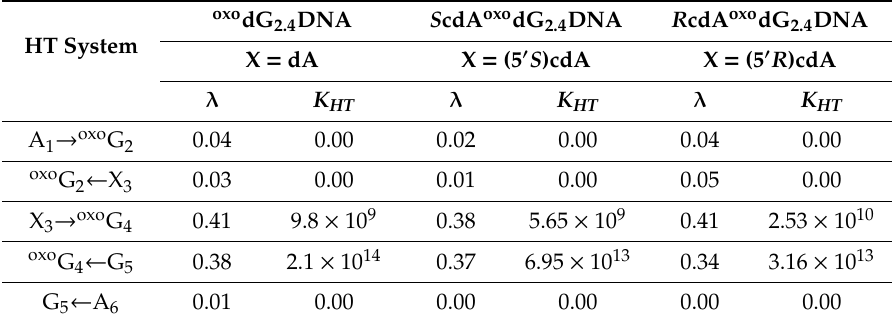
Table 1. The λ [eV] and K HT [s − 1 ] of hole transfer between base pairs, calculated at the m062x / 6-31 + G** level of theory in the aqueous